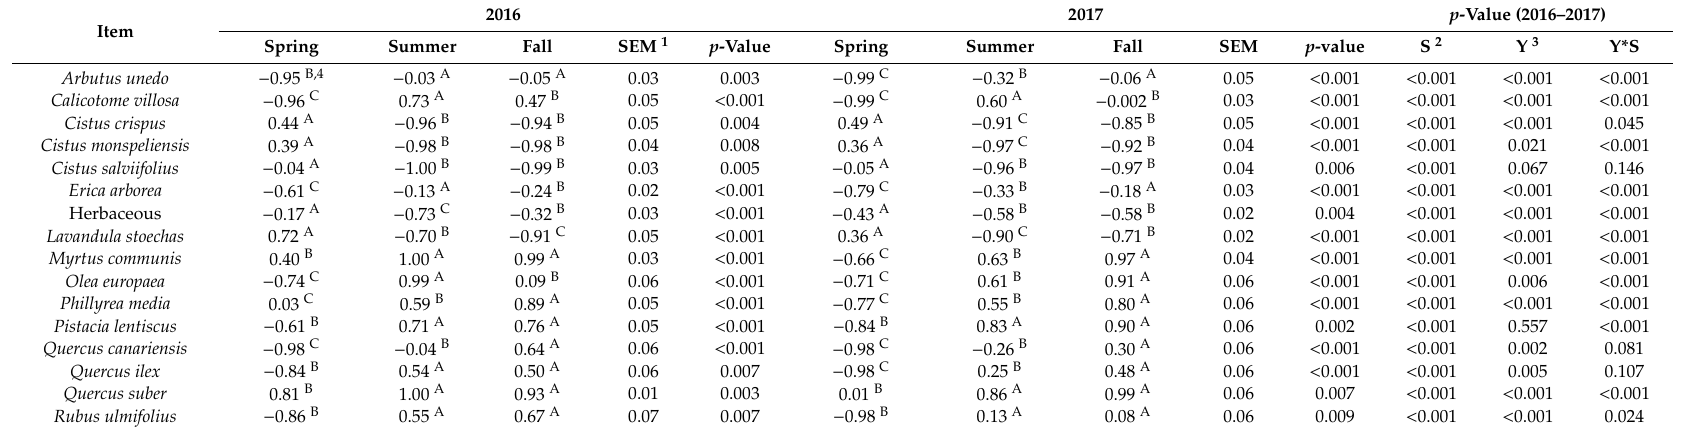
Table 5. Selectivity index of plant species consumed by goats browsing a Southern Mediterranean forest rangeland during 2016 and 2017.